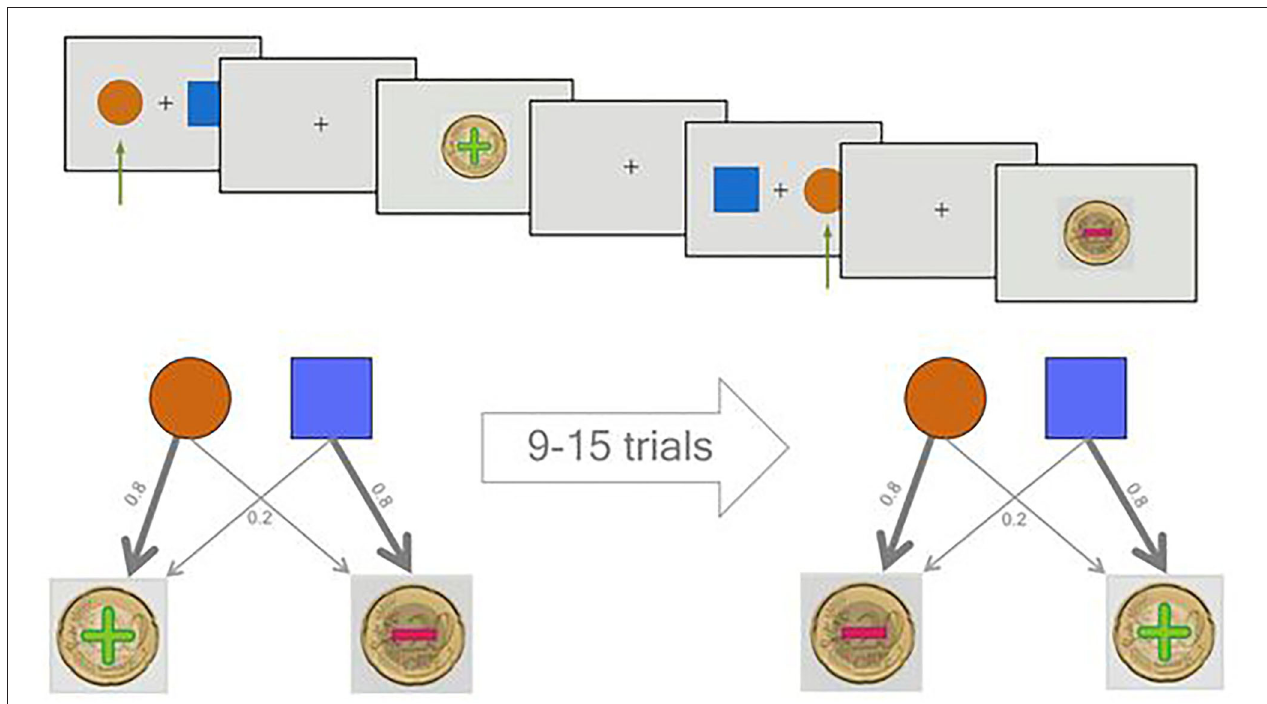
FIGURE 1 | Overview of the probabilistic reversal learning (PRL) task. In the upper half of the picture, two sample trials of the task are displayed. Two sample trials are shown. The green arrow shows the selection of the participant. The first decision leads to a reward and the second to a punishment. In the lower, the probabilistic character of the task is